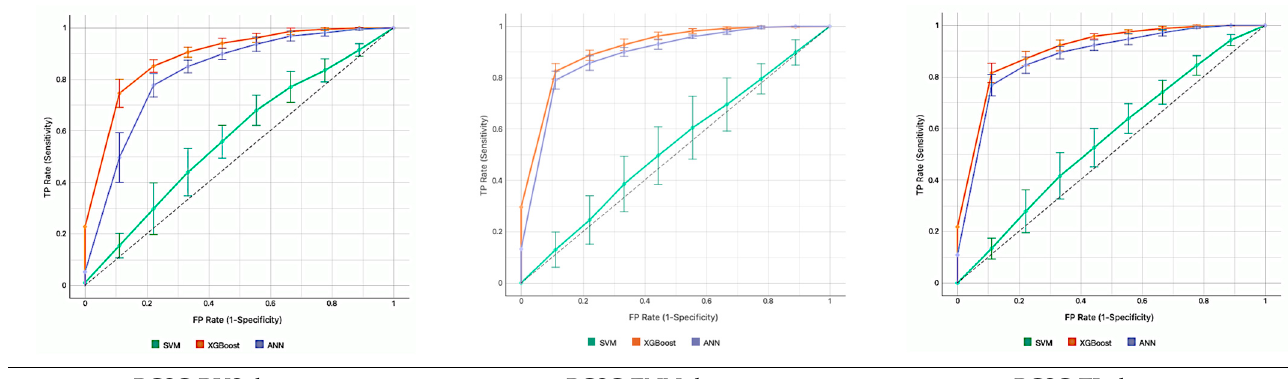
Table 13. ROC analysis of all the models based on the datasets balanced using undersampling techniques.